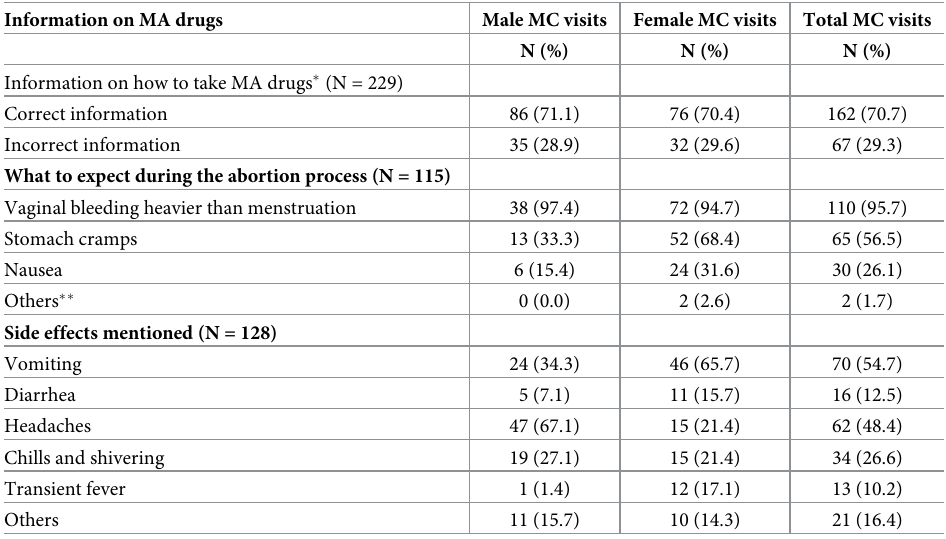
Table 4. Information on how to take MA drugs, and side